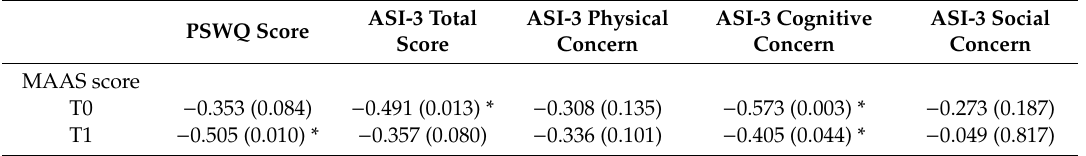
Table 3. Correlations (rho and p values in brackets) between trait mindfulness, worry, and anxiety. ASI-3 Total ASI-3 Physical ASI-3 Cognitive ASI-3 Social PSWQ Score Score Concern Concern